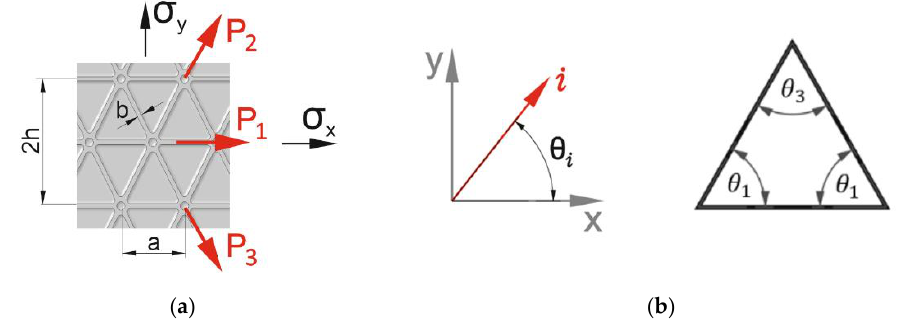
Figure 1. Forces in grid ( a ) and angle definitions ( b ).